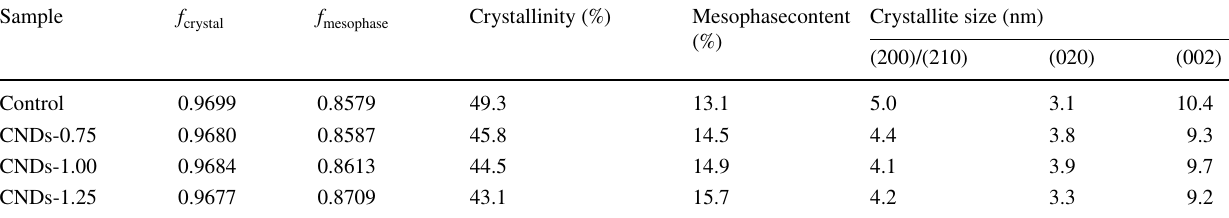
Table 2 Herman’s orientation function and crystallinity parameters of degummed silks